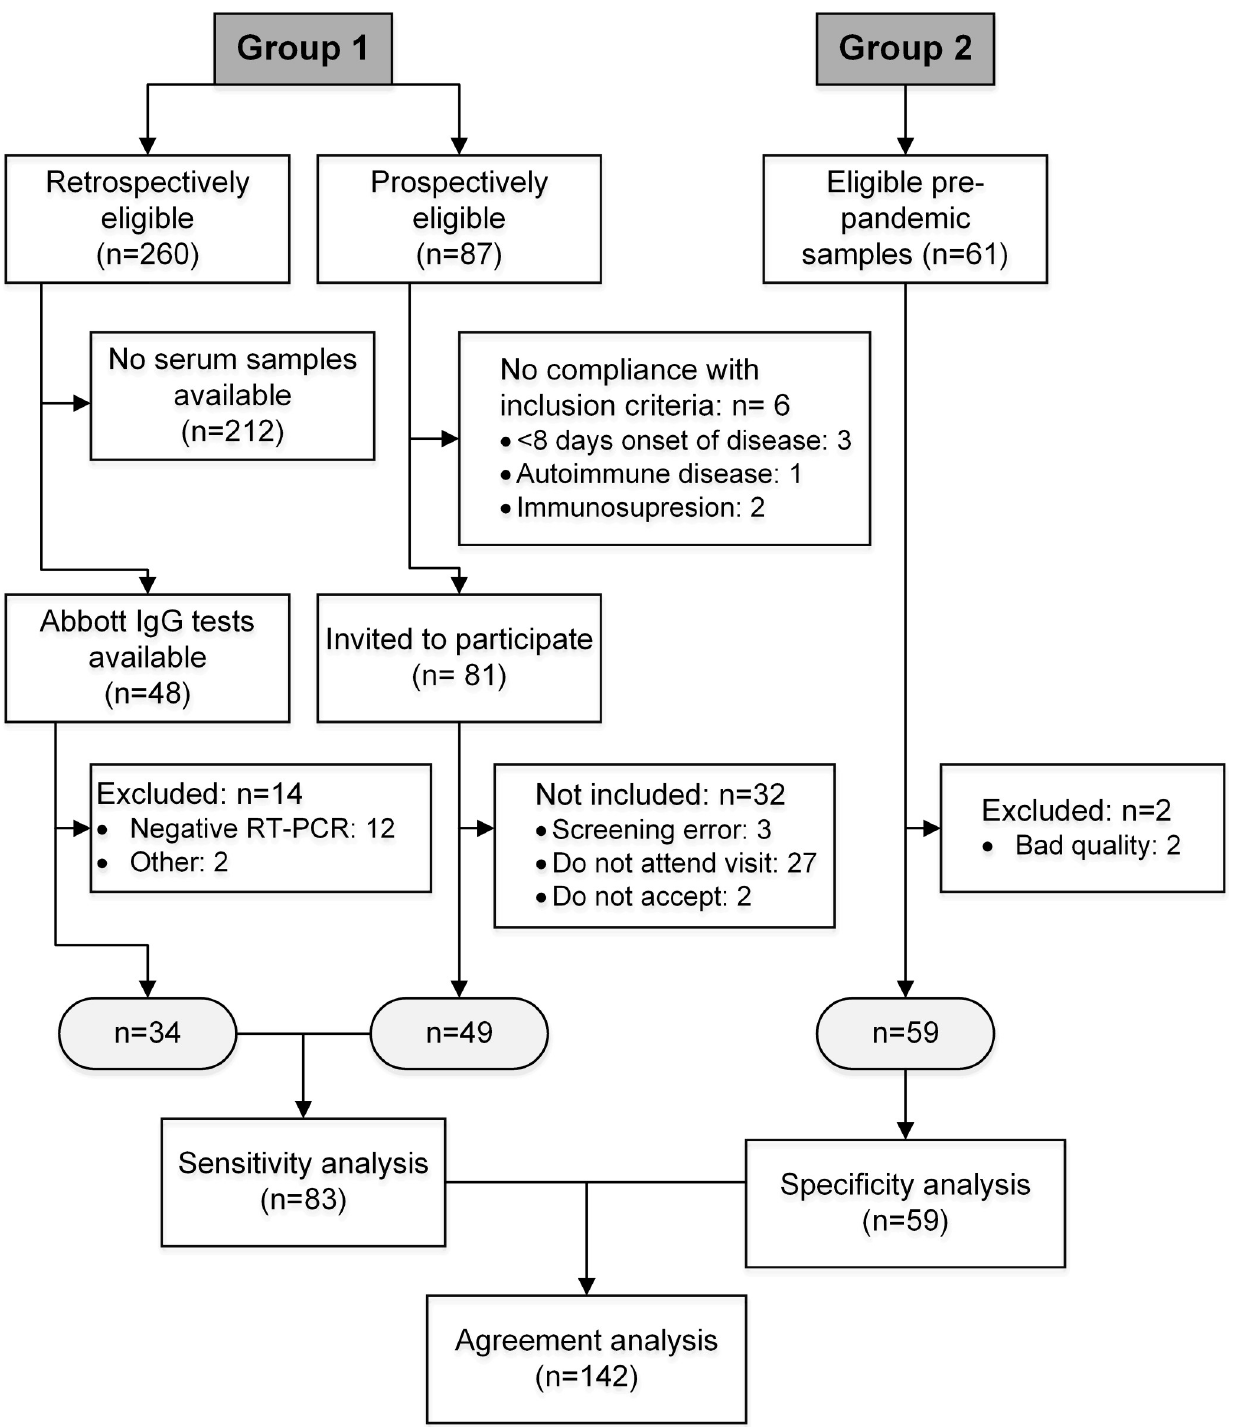
Fig 1. Schematic representation of the study design and conduct. Flow diagram of the performance verification study. Shown are all eligible and recruited patients and samples, as well as reasons for exclusion of participants during the study. Group 1: SARS-CoV-2 infected patients and samples. Group 2: Pre-pandemic